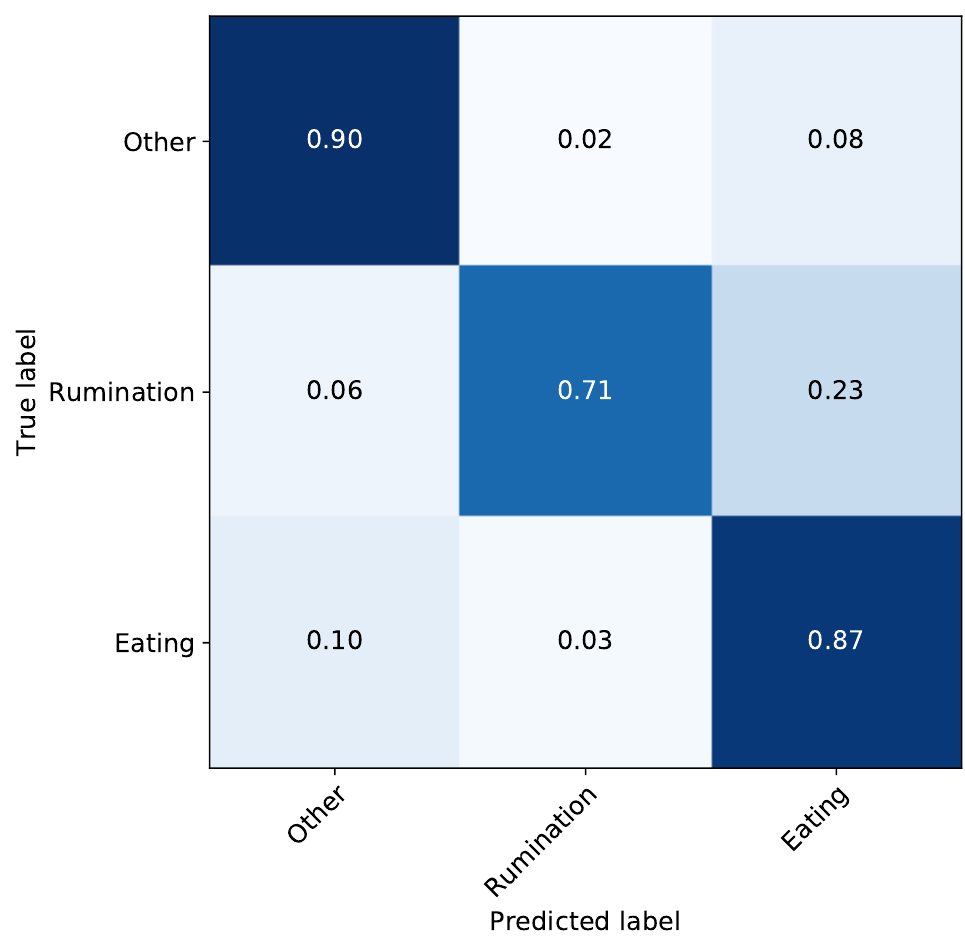
Figure 7. Confusion matrix of the full network after hyper-parameter tuning—test